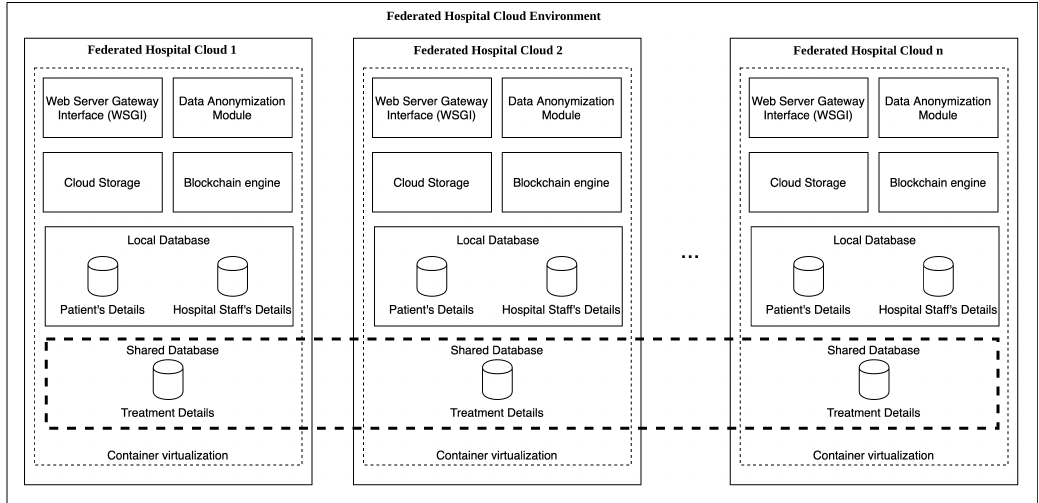
Figure 2. Federated Hospital Internet of Things (IoT) Cloud (FHC)